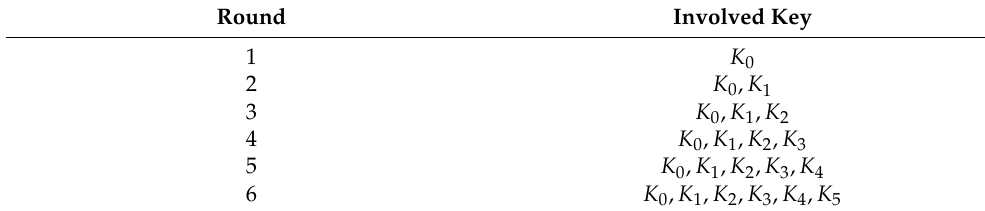
Table 3. Key involved in first six rounds of encryption. Round Involved